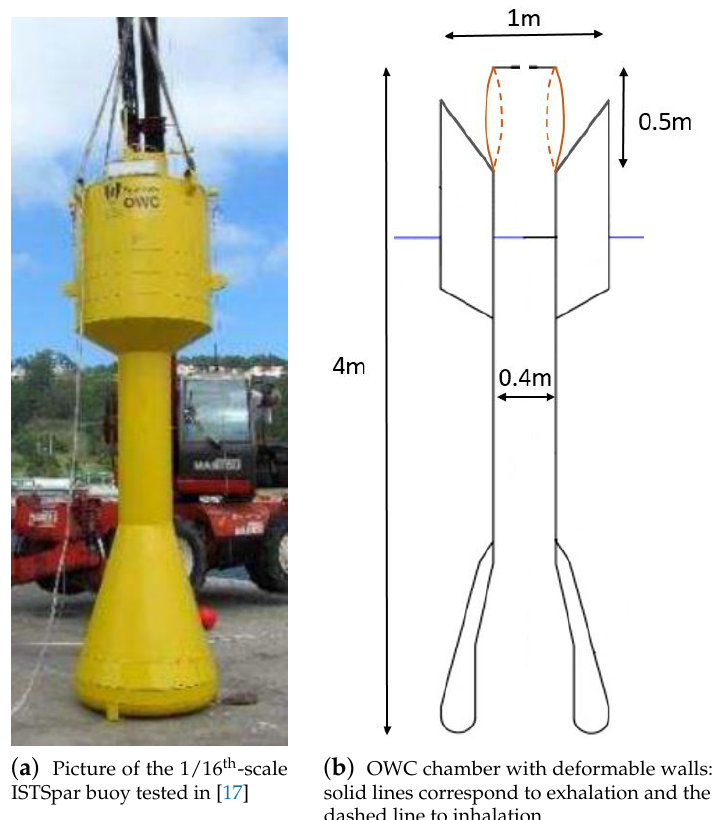
( a ) Picture of the 1/16 th -scale ( b ) OWC chamber with deformable walls: ISTSpar buoy tested in [17] solid lines correspond to exhalation and the dashed line to inhalation Figure 5. Suggestion for practical application of a deformable air chamber to model air compressibility on the IST Spar